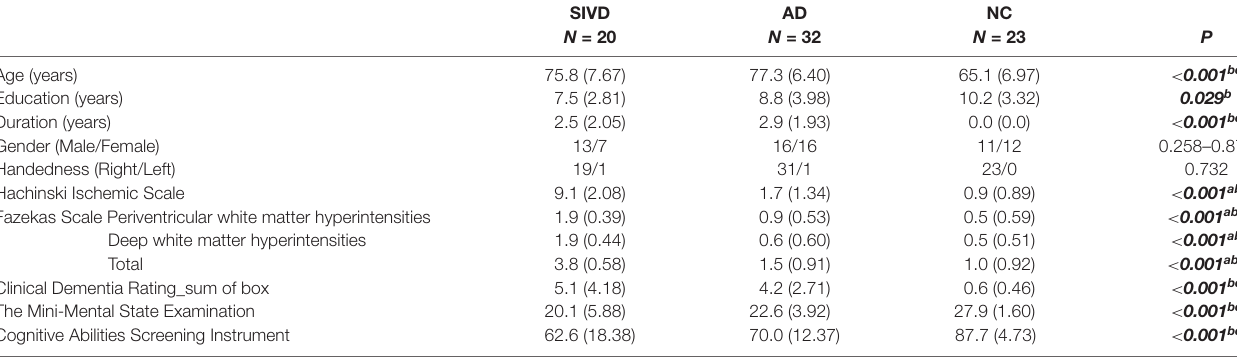
TABLE 1 | Demographic data comparisons among subjects with SIVD, AD and